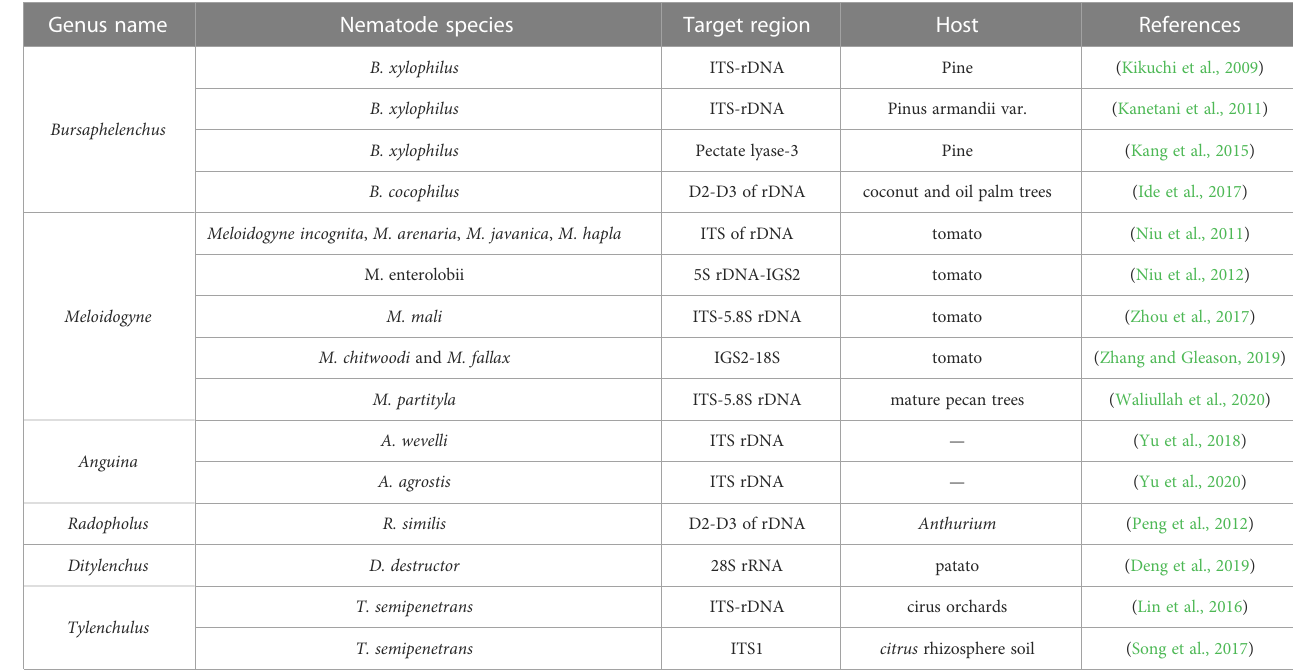
TABLE 2 The application of the LAMP technique to plant parasitic